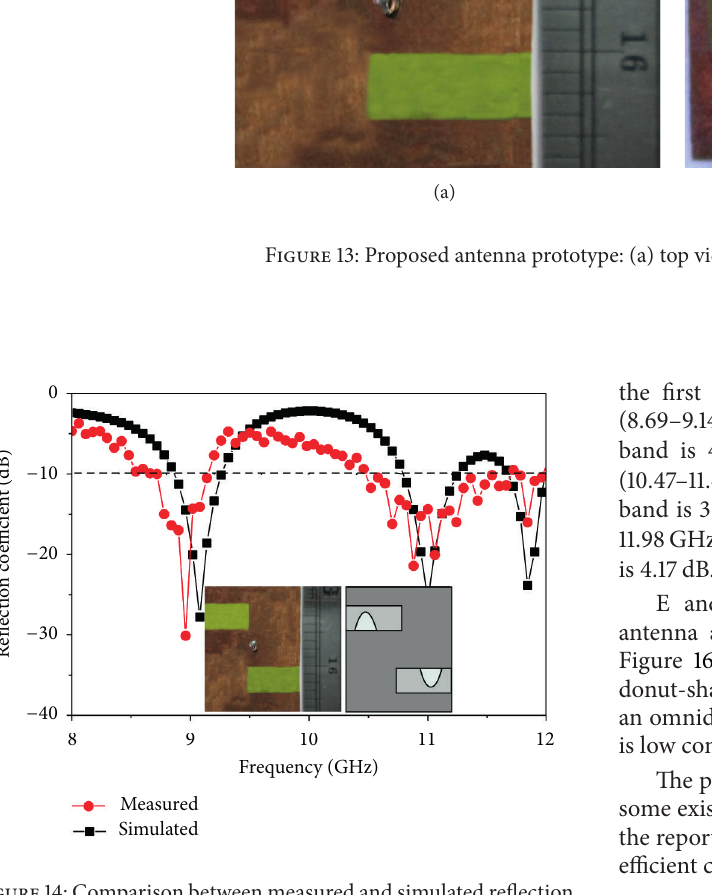
Figure 14: Comparison between measured and simulated reflection coefficient.